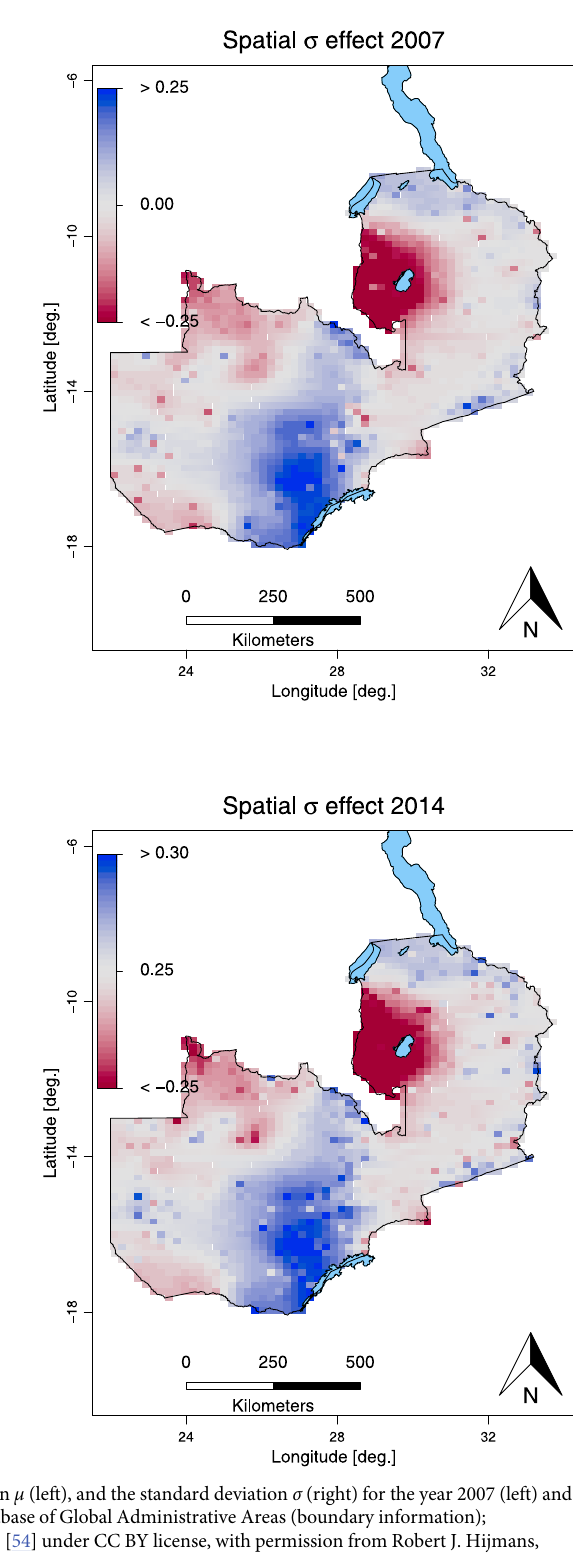
PLOS ONE | https://doi.org/10.1371/journal.pone.0255073 August 4,